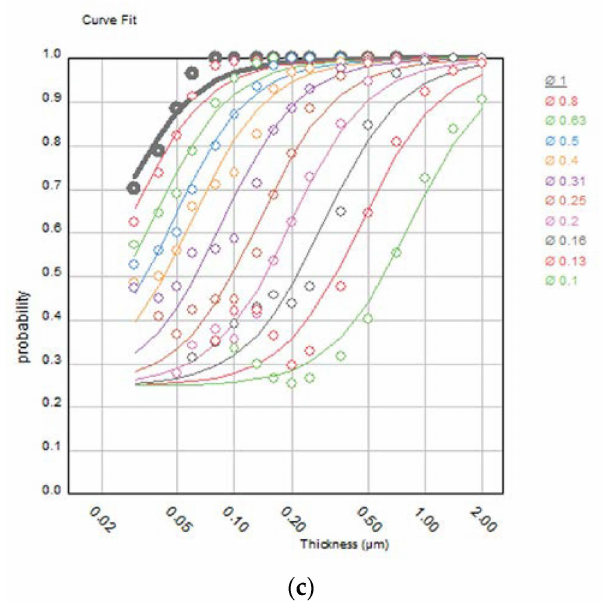
Figure 2. Examples of the output of the CDMAM3.4 Analyser software: ( a ) contrast–detail score diagram, ( b ) contrast–detail curves for each individual image (thin colored lines) and the average curve (thick blue line) for all images, ( c ) average psychometric detection probability (data points and fitted curves) for all images in relation to gold disk thickness and disk diameter.